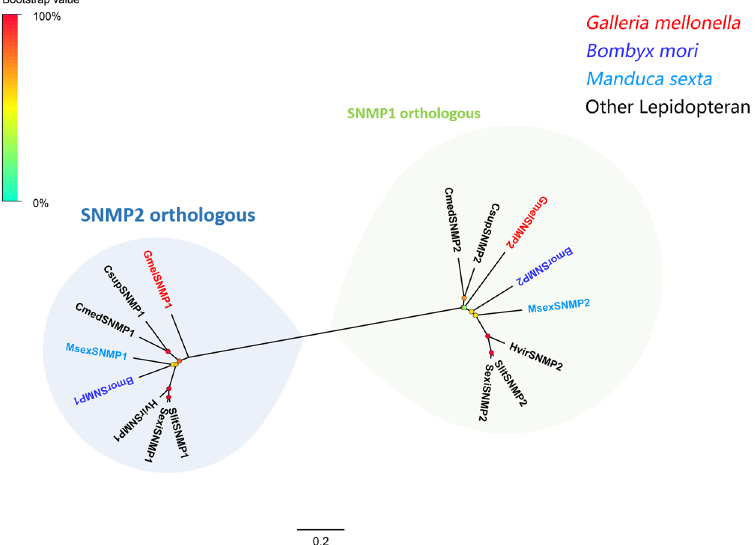
Figure 3. Maximum-likelihood tree of SNMPs. Species abbreviations: Gmel, Galleria mellonella ; Bmor, Bombyx mori ; Cmed, Cnaphalocrocis medinalis ; Msex, Manduca sexta ; Snon, Sesamia nonagrioides ; Slit, Spodoptera littoralis ; Hvir, Heliothis virescens . Highlighted clades: SNMP1 clade (green) and SNMP2 clade (blue). Node support (circles at the branch nodes) was estimated using an approximate likelihood ratio test based on the scale indicated at the top left. Bars indicate branch lengths in proportion to amino acid substitutions per